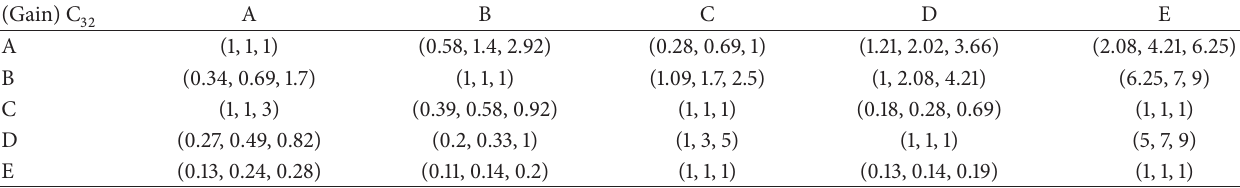
Table 10: Options concerning gain subcriteria.